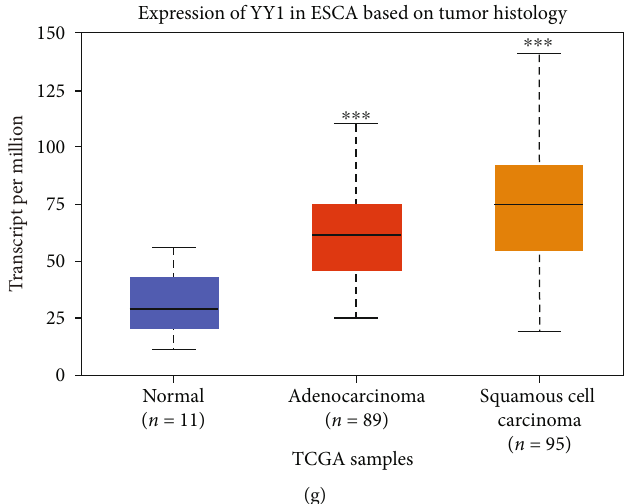
Figure 2: Analysis results of expression of YY1 in ESCA subgroups. (a – g) Box plot shows the mRNA expression of YY1 in normal individuals or in ESCA individual cancer stages, patient ’ s race, nodal metastasis status, patient ’ s age, patient ’ s smoking habits, TP53 mutation status, and tumor histology. ∗ P < 0 : 05 , ∗∗ P < 0 : 01 , and ∗∗∗ P < 0 : 001 ; ns: no signi fi